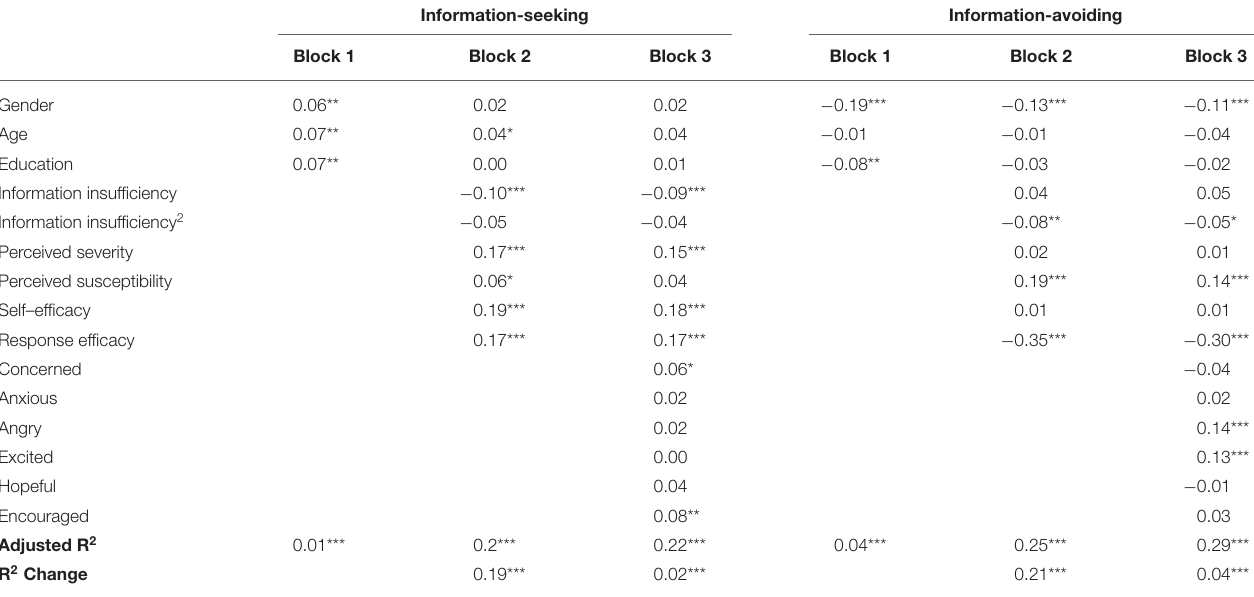
TABLE 3 | Hierarchical multiple regression effects on information-seeking and information-avoidance behaviour.